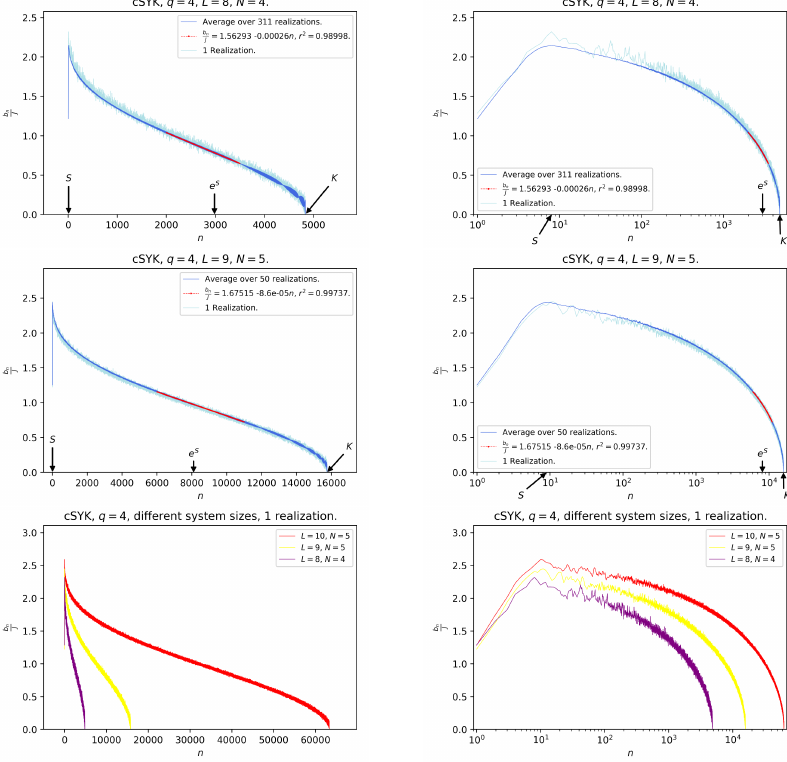
Figure 4 . Lanczos sequences for L = 8 , N = 4 and L = 9 , N = 5 and comparison of results for L = 8 , 9 , 10 . Top row: results for L = 8 in linear (left panel) and logarithmic (right panel) scale along the horizontal axis. The plots depict both the sequence of a single random realization and the average over 311 realizations. A linear fit is included in the decaying tail, whose slope approaches numerically the naïve estimate ∼ − 1 ≈ − 0 . 000206 . Middle row: results for L = 9 in linear (left K panel) and logarithmic (right panel) scale along the horizontal axis. The plots depict both the sequence of a single random realization and the average over 50 realizations. A linear fit is included in the decaying tail, whose slope is of the order of the naive estimate ∼ − 1 ≈ − 6 . 3 · 10 − 5 . Bottom K row: comparison of the Lanczos sequences for L = 8 , 9 , 10 in linear (left panel) and logarithmic (right panel) scale along the horizontal axis.